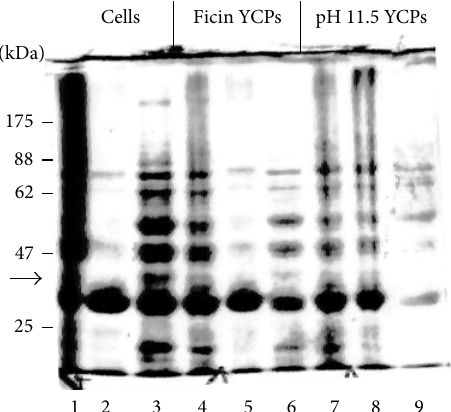
Figure 9: SDS-PAGE of proteins from cells and YCPs expressing U65-GFP (34.1kDa, arrow). For each set, the first lane shows total proteins, the second is 16,000 × g pellet, and the third is 16,000 × g supernatant. Lanes 1–3, cells. Lanes 4–6, YCPs made by ficin hydrolysis. Lanes 7–9, YCPs made by hydrolysis at 45 ∘ C, pH 11.5 to